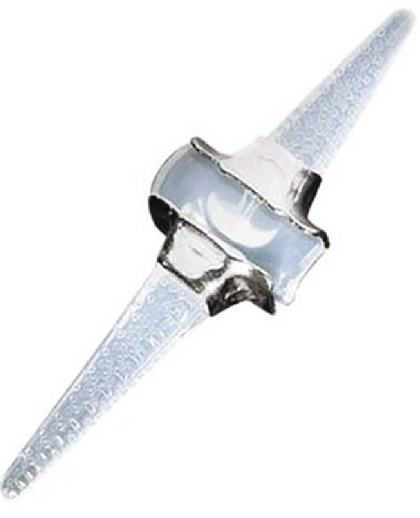
Figure 3: Fatigue fracture of Swanson fi nger implant at the junction of hinge and